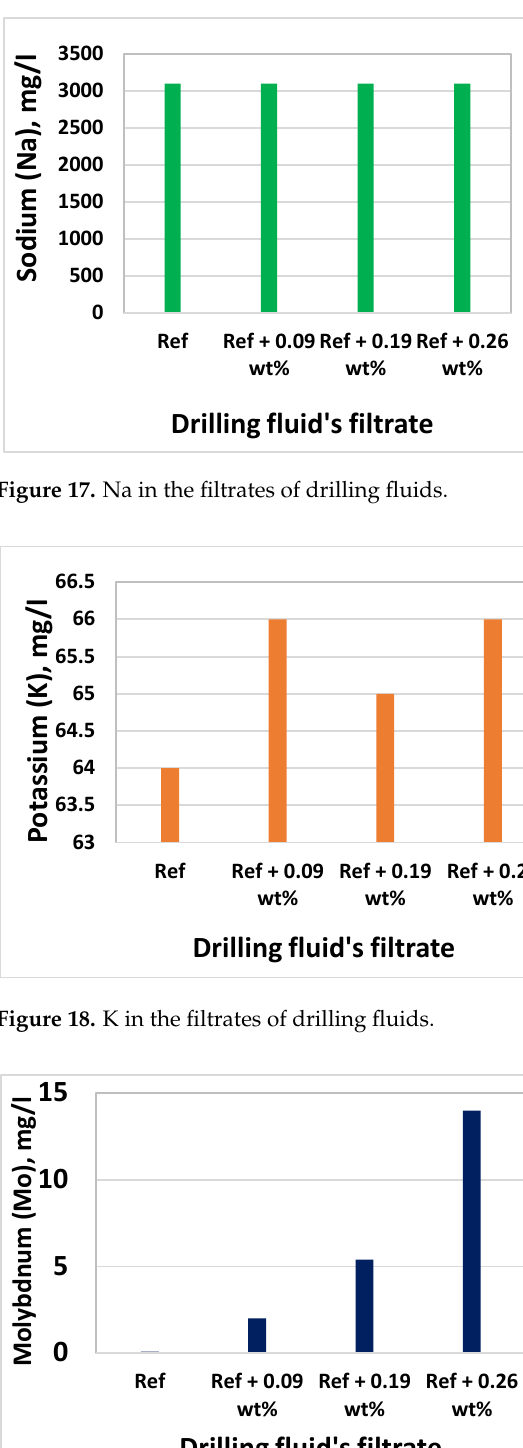
Figure 20. S in the filtrates of drilling fluids. 4. Discussion Drilling is a cost factor the oil and gas industry. Drilling activities becomes more complex in HPHT -and in depleted formation. Moreover, in an extended reach horizontal wells and in deep water depth, where the drilling operational window is narrow. In order to handle the narrow window and depleted formation operational challenges, the indus- try developed new drilling methods called managed pressure -and under pressure drill- ing methods, respectively. However, for conventional and the new drilling methods, the quality of the drilling fluid property is still essential. An efficient, cost effective and environmentally friendly drilling fluids are key for the successful drilling operation. Poorly designed drilling fluids results undesired operational challenges such as differential sticking, high drag, poor hole cleaning, and difficulty in well pressure control and resulting kick, well collapse and well fracturing. [1] Survey conducted on the European wells in 1989-2007 showed the increase drilling efficiency per day, which is due to an improved PDC bit technology. However, the study indicated a flat non-productive time that accounts about 25%].[59] In deep-water and ex- tended reach well, the NPT observed up to 40%.[59] Wells drilled Gulf of Mexico during 1993 – 2002 also showed that the non-productive time accounts about 24%.[60] The factors that contribute to the NPT are lost circulation, stuck pipe, kick, wellbore instability, equip- ment failure, cement squeeze operations, directional control, weather delay and equip- ment handling. Among these, loss circulation, kick and stuck pipe account about one third of the overall NPT incidents. [61] These problems are in one or another way has connec- tion with drilling fluids. It is therefore important to design good drilling fluids to mini- mized drilling fluid related undesired operational events.